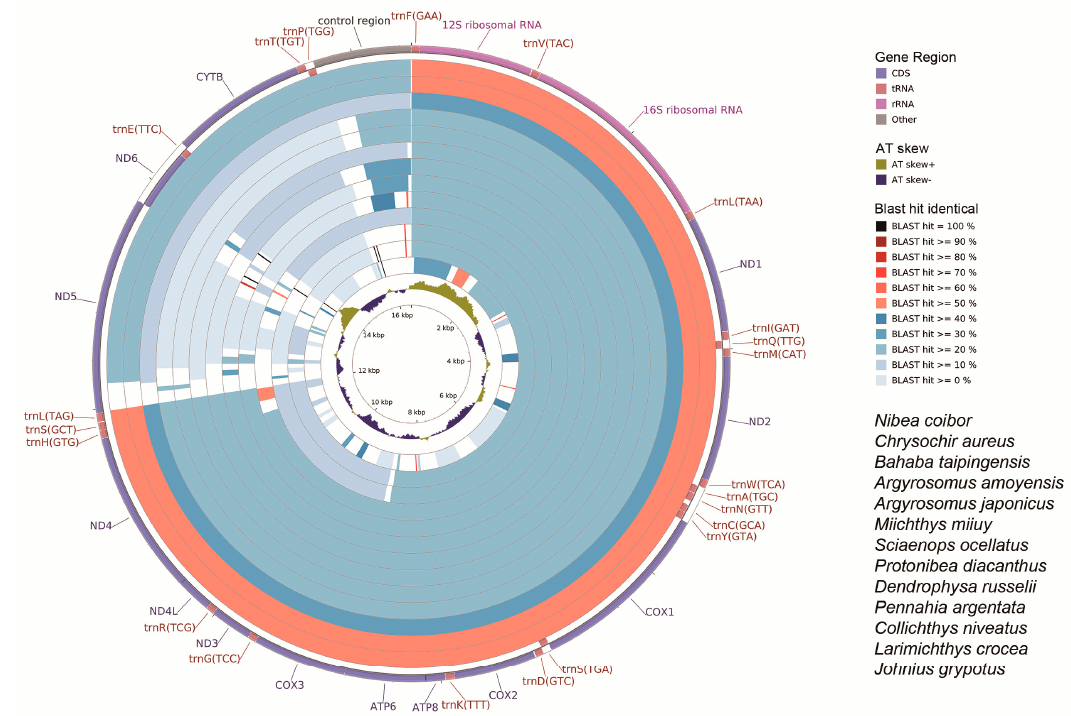
Figure 6. Graphical map of the BLAST results showing nucleotide identity between the complete mitochondrial genomes of Nibea albiflora (NC_015205) (Perciformes, Sciaenidae) and other Sciaenidae species, using the CGView comparison tool (CCT). CCT arranges BLAST result in an order where sequence that is most similar to the reference ( N. albiflora ) is placed closer to the outer edge of the map. Note: gene region, Blast identity, and AT skew are shown from outside to inside. The species from outside to inside as follows, respectively: Nibea coibor , Chrysochir aureus , Bahaba taipingensis , Argyrosomus amoyensis , A. japonicas , Miichthys miiuy , Sciaenops ocellatus , Protonibea diacanthus , Dendrophysa russelii , Pennahia argentata , Collichthys niveatus , Larimichthys crocea , and Johnius grypotus .